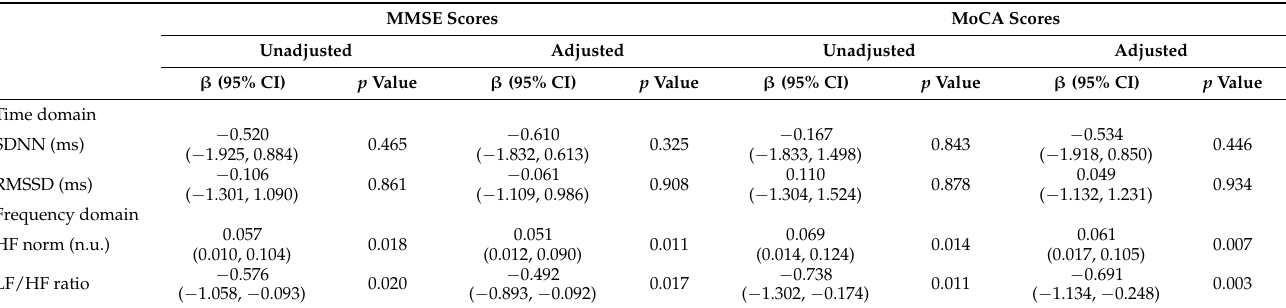
Table 3. Associations between HRV parameters and MMSE and MoCA scores among total CSVD